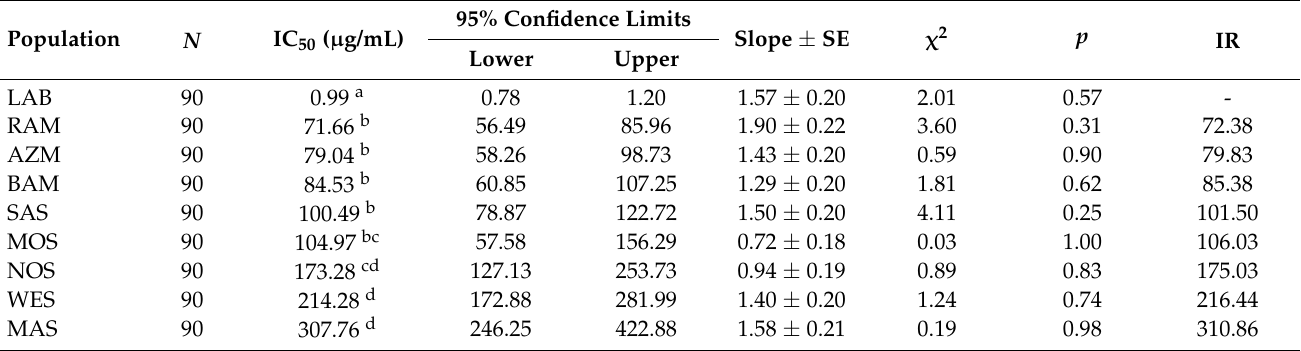
Table 6. Fenitrothion median inhibitory concentration (IC 50 ) and AChE inhibition resistance ratio